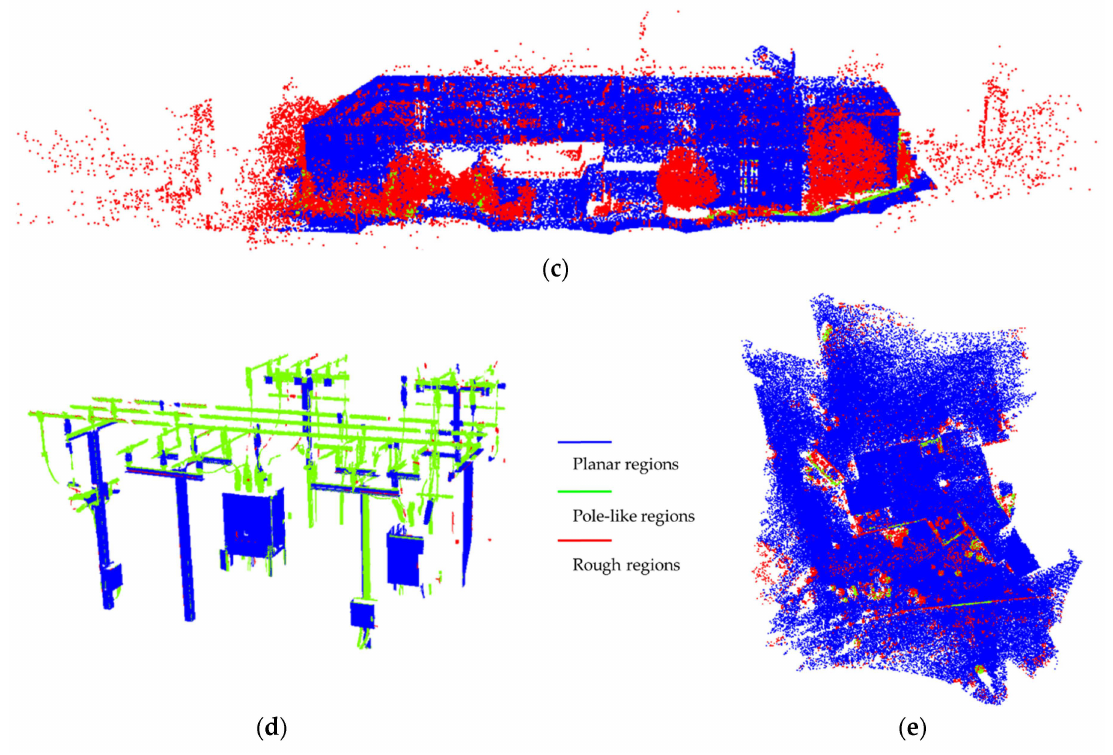
Figure 9. Perspective views of the classified point clouds for the ALS ( a ); TLS1 ( b ); TLS2 ( c ); TLS3 ( d ); and DIM ( e ) datasets (planar, pole-like, and rough regions are shown in blue, green, and red, respectively).